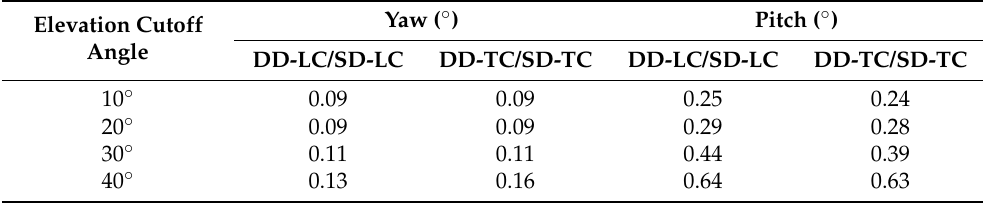
Table 6. The yaw and pitch RMS errors of the DD-LC, DD-TC, SD-LC, and SD-TC models under different elevation cutoff angles in the single-epoch